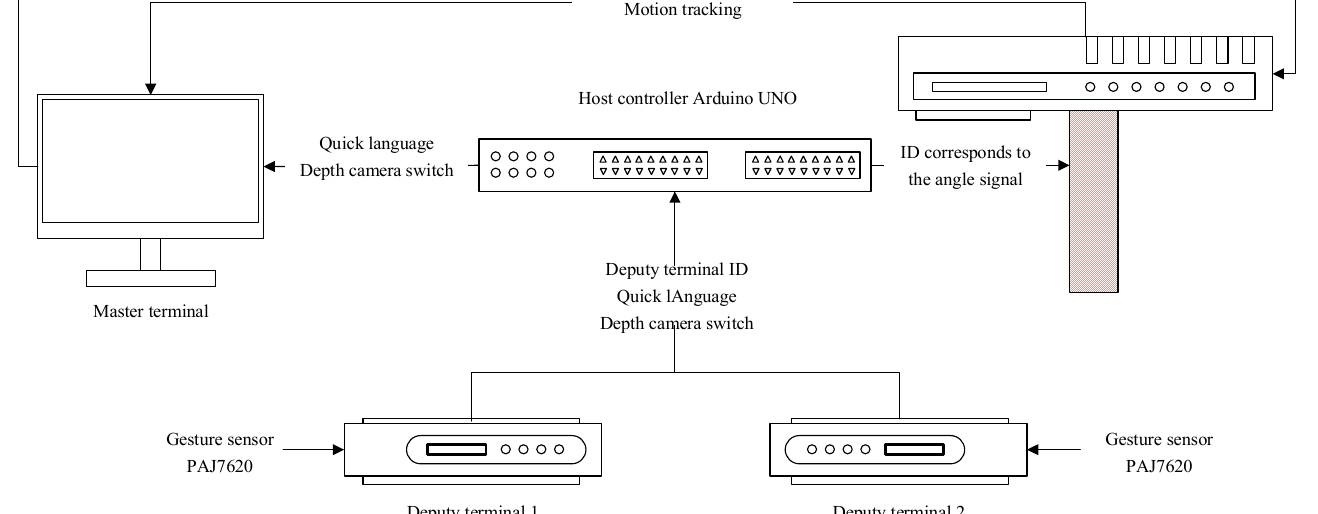
Figure 2. The system.